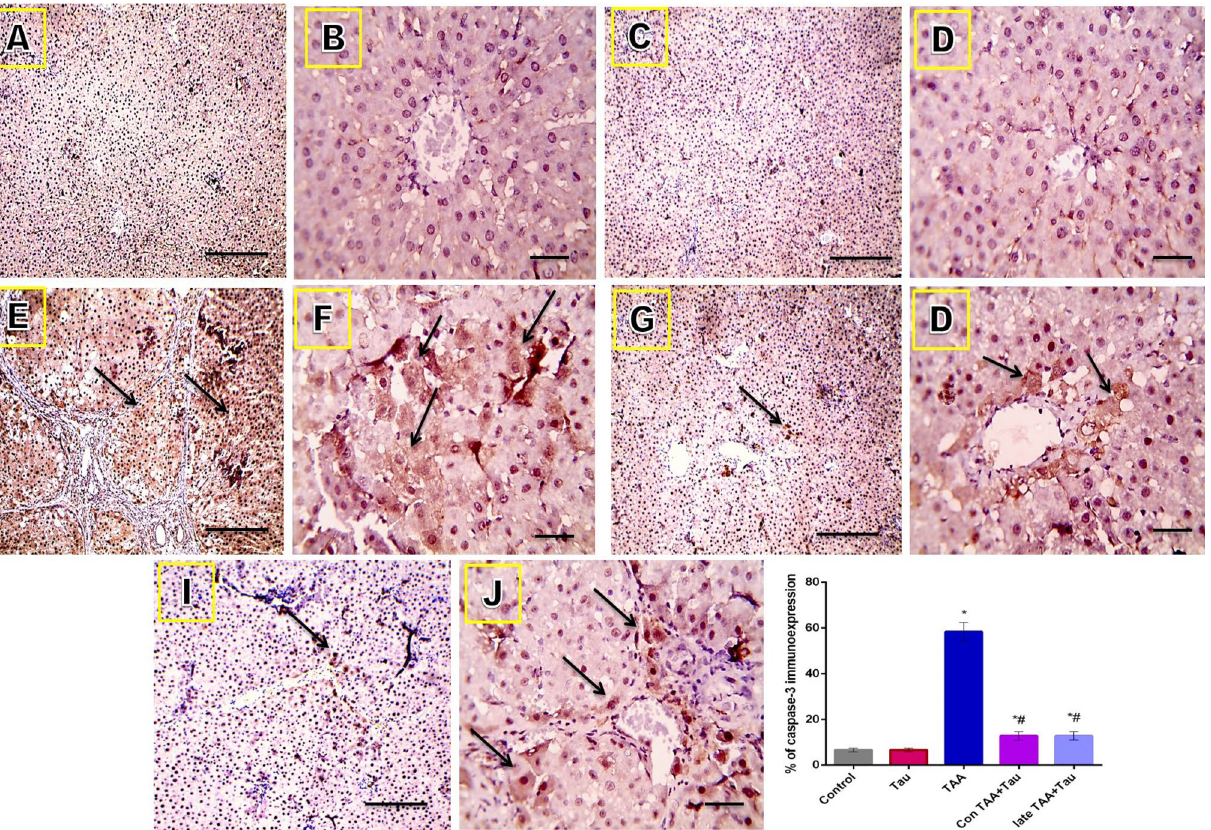
Figure 7. Microscopic pictures of immunostained liver sections against caspase-3. ( A ) control group. ( B ) Tau group. ( C ) TAA group. ( D ) Con TAA + Tau group. ( E ) late TAA + Tau group. ( F ) % of